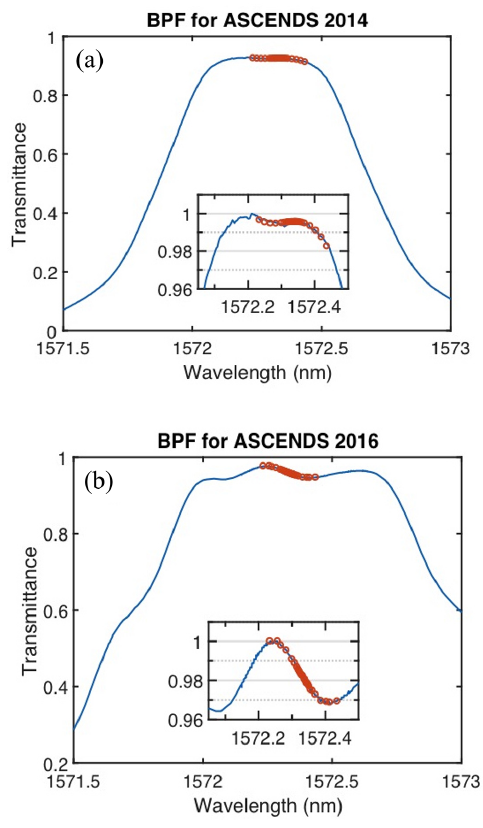
Figure 5. Plots of transmission vs. wavelength for the optical band- pass filters (BPF) used in the lidar receiver. (a) Filter used for the 2014 flights and (b) filter used for the 2016 flights. The insets show expanded views of the peak filter transmissions at the lidar mea- surement wavelengths (red dots). The 2016 filter was purchased in an attempt (which was unsuccessful) to flatten the response at the li- dar measurement wavelengths. The lidar retrieval algorithm solves for the variability in instrument transmission at the measurement wavelengths introduced by the filters.